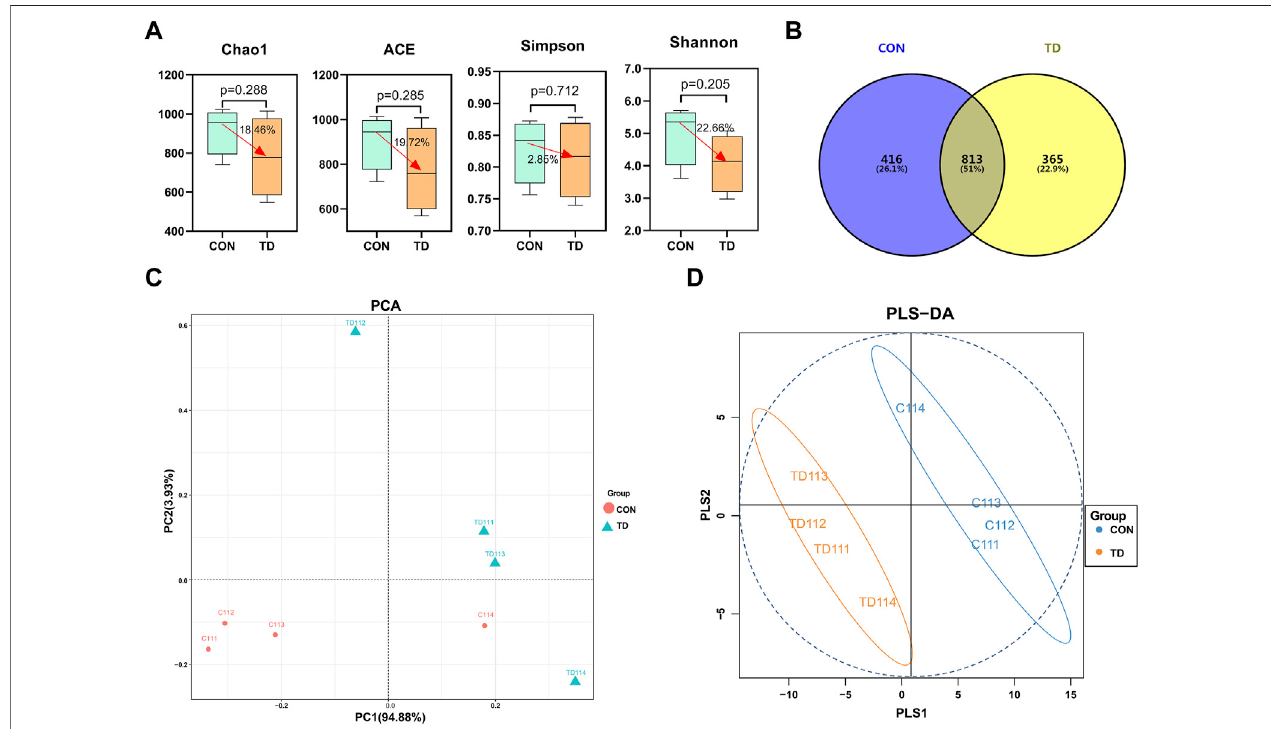
FIGURE 2 | Fecal microbial overall structure of broiler chickens. (A) Chao1, ACE, Simpson, and Shannon indices from the CON and TD groups were used to analyze the alpha diversity. Statistical analysis was performed by Kruskal-Willis test, a p -value lower than 0.05 ( < 0.05) has statistically signi fi cant, N = 4. (B) The Venn diagramshowedthecommonanduniqueOTUsintheCONandTDgroupsofbroilerchickens. (C) UnweightedUnifracPCAestimatesforthegutmicrobiotaoftheCON group (red) and TD group (green). (D) OPLS-DA analysis of gut-microbiota in the CON group (green) and TD group (orange-yellow) of broiler chickens.